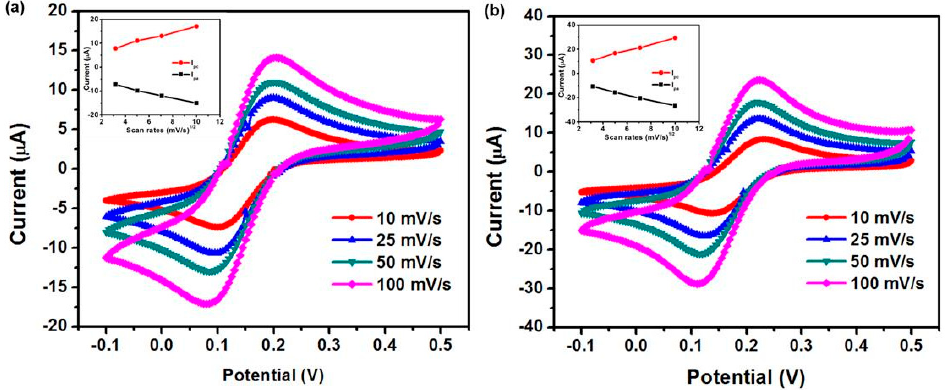
Figure 5. Cyclic voltamamograms on paper-based electroanalytical devices of the two working electrodes of different thicknesses in 5 mM K 3 [Fe(CN) 6 ] as a redox probe in 1X PBS (pH 7.4) buffer at different scan rates. ( a ) 100-layered HA-CNT sheet, ( b ) 200-layered HA-CNT sheet. (Insert: shows plots of the redox peak currents vs. the square root of scan rate).